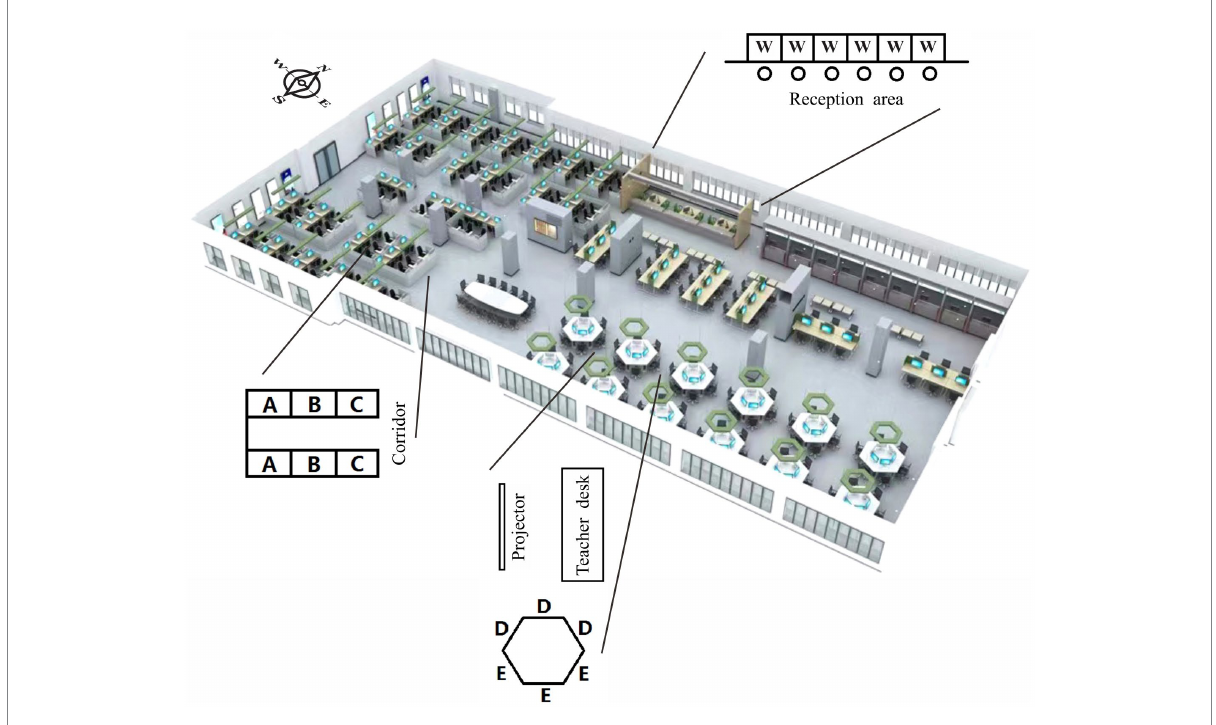
FIGURE 1 Layout of the classroom and seat